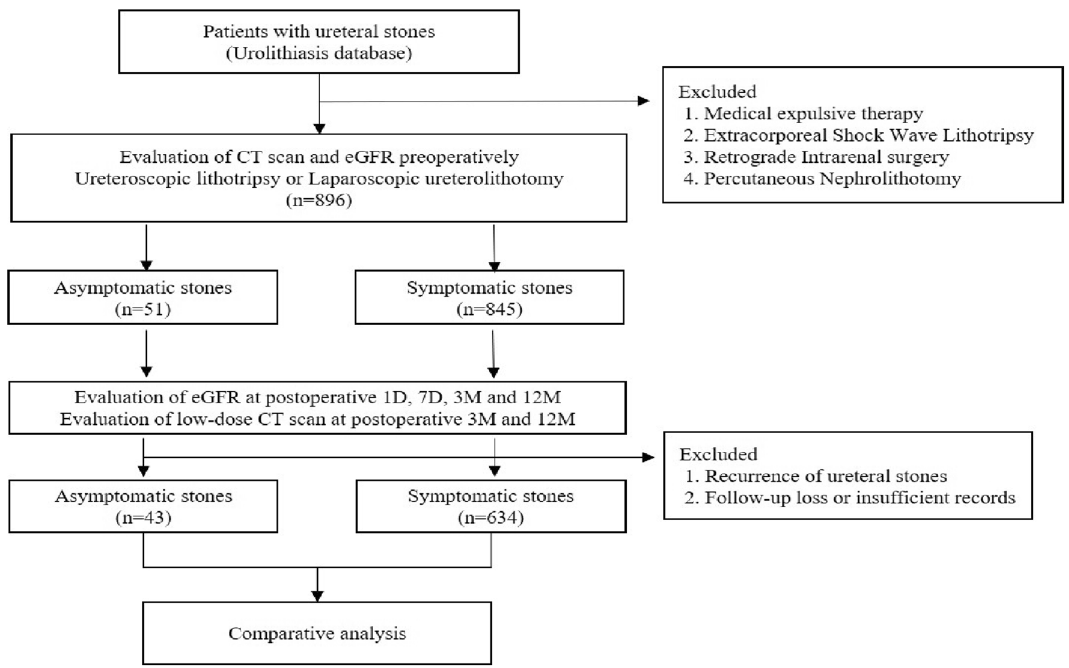
Figure 1. Flowchart for study design. CT, computed tomography; D, day; eGFR, estimated glomerular filtration rate; M,